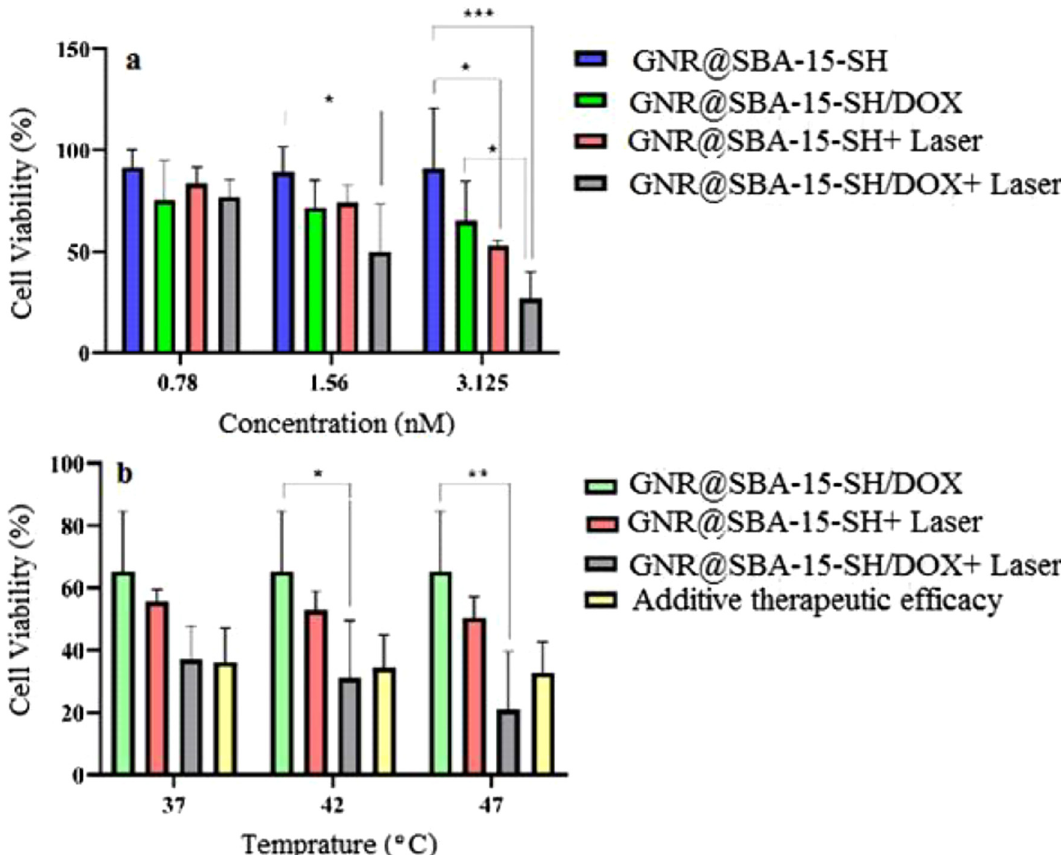
Figure 13: (a) Relative viabilities of A549 cells incubated with GNRs@SBA-15-SH or GNRs@SBA-15-SH/DOX at different concentrations under exposure to a 808 nm laser at a power density of 3.6 W/cm 2 for 10 min, * p ˂ 0.05, *** p = 0.0002, n = 3, (b) A comparison of cell viability